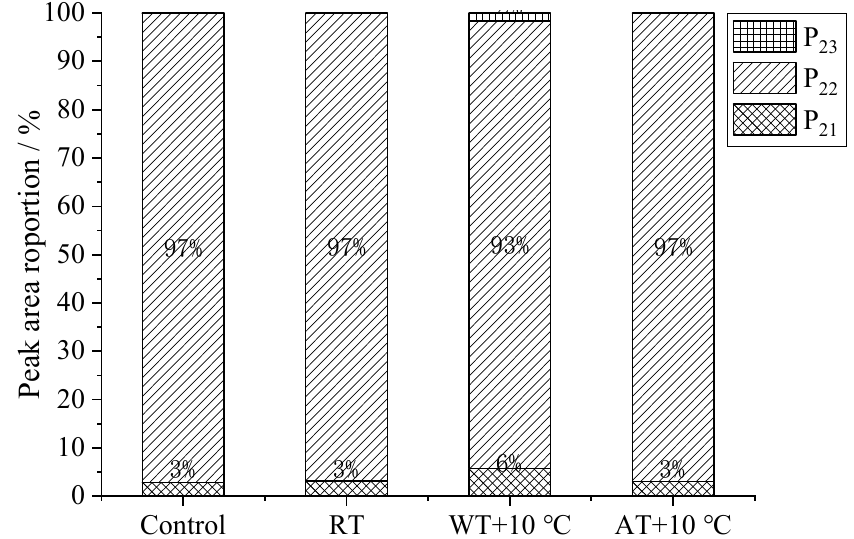
Figure 7. The relaxation time ( T 2 ) corresponding relative populations ( P 21 , P 22 and P 23 ) of salmon fillets after different tempering treatments. (RT: Radio frequency tempering; WT+10 ˚ C: Water tempering at 10 ± 0.5 ˚ C; AT+10 ˚ C: Air tempering at 10 ± 1 ˚ C).